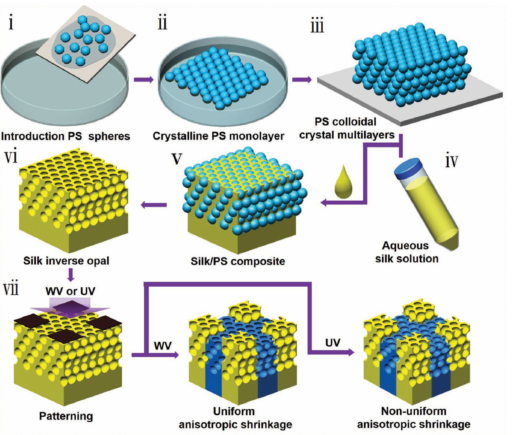
Figure 5. Three-Dimensional silk photonic crystal : ( i ) PS beads are deposited over the water surface via a hydrophilic substrate. ( ii ) The sphere forms a crystalline monolayer at the water/air interface through self-assembly. ( iii ) Colloidal crystals are generated by subsequent scooping transfer procedures from the water/air interface to the sphere-coated substrate. ( iv ) The aqueous silk solution prepared as mentioned before is ( v ) introduced in the so-formed PS sphere 3D photonic crystal. ( vi ) The silk 3D inverse opal is obtained by dissolving the polystyrene beads in toluene. ( vii ) The silk inverse opal is shadow-masked and exposed to WV (water vapor) or UV light to obtain the desired pattern. Reproduced with permission from reference